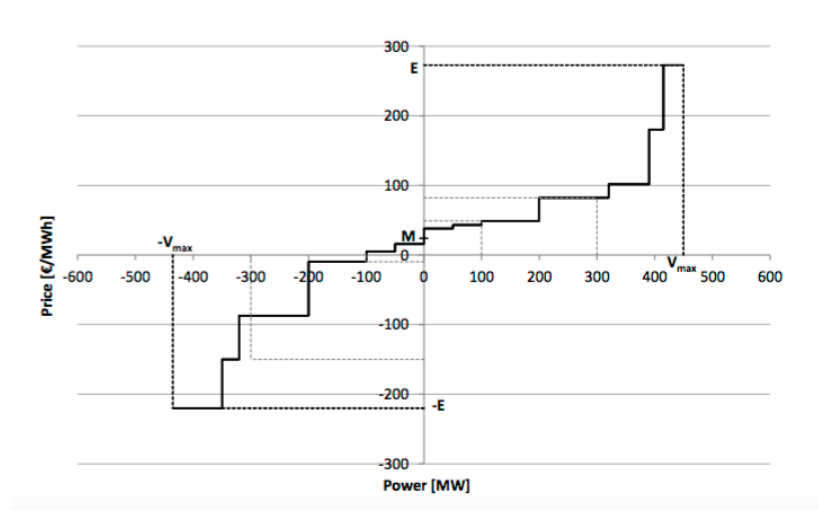
Figure 1. Schematic of Dutch control reserve bidding ladder